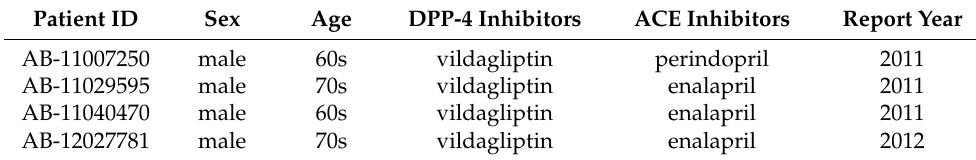
Table 5. Data of patients on the concomitant use of DPP-4 inhibitors and ACE inhibitors. Patient